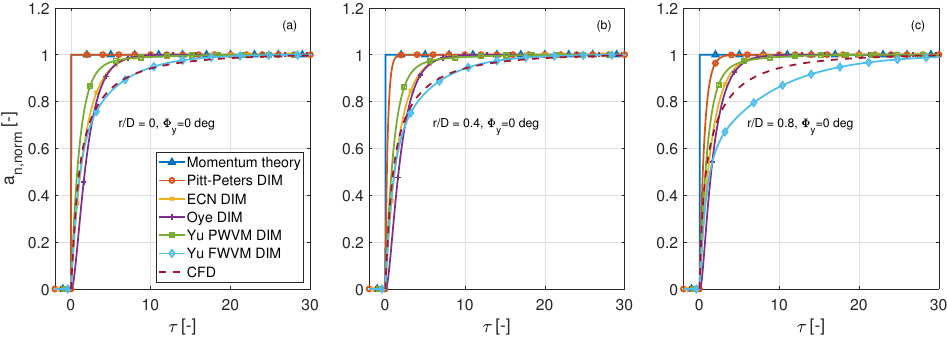
Figure 5. Normalized induction factor a n , norm at different positions when base C T = 0.6, step ∆ C Φ y = 0 deg, ( a ) r/D = 0 ( b ) r/D = 0.4 ( c ) r/D = 0.8, τ is Non-dimensionalized time T = +0.1,